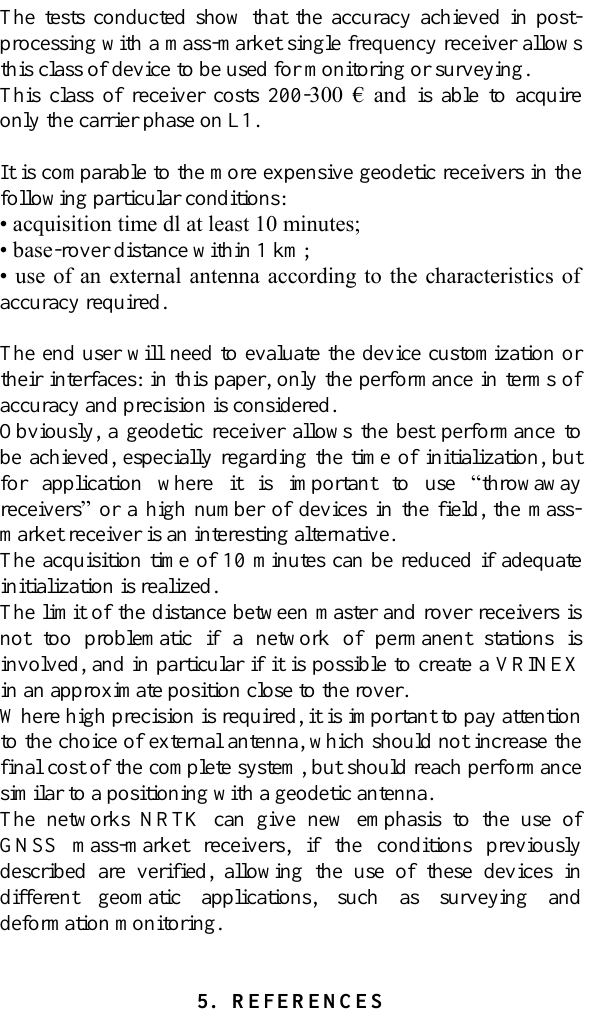
Table 19 . Residuals [mm] –